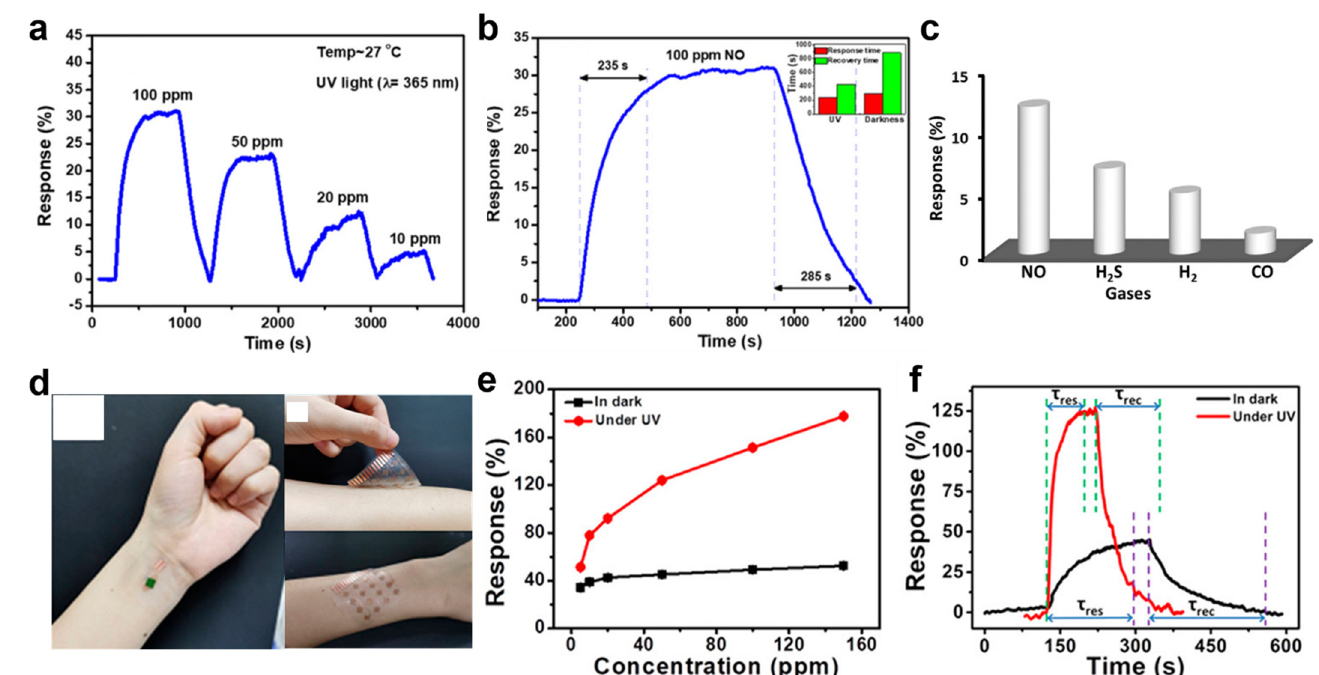
Figure 2. ( a ) Response of the TiO 2 @NGQDs sensor under UV irradiated; ( b ) response and recovery times of TiO 2 @NGQD sensors with UV − on and UV − off; ( c ) selectivity characteristics of the TiO 2 @NGQDs sensor (adapted from [85] with permission from the American Chemical Society); ( d ) image of the flexible and wearable TiO 2 @NGQDs sensor with human arm and wrist; ( e ) response of the Cu − TCA/TiNCs sensor ppb with UV − on and UV − off; ( f ) response and recovery time of the Cu − TCA/TiNCs sensor (adapted from [86] with permission from the American Chemical Society).